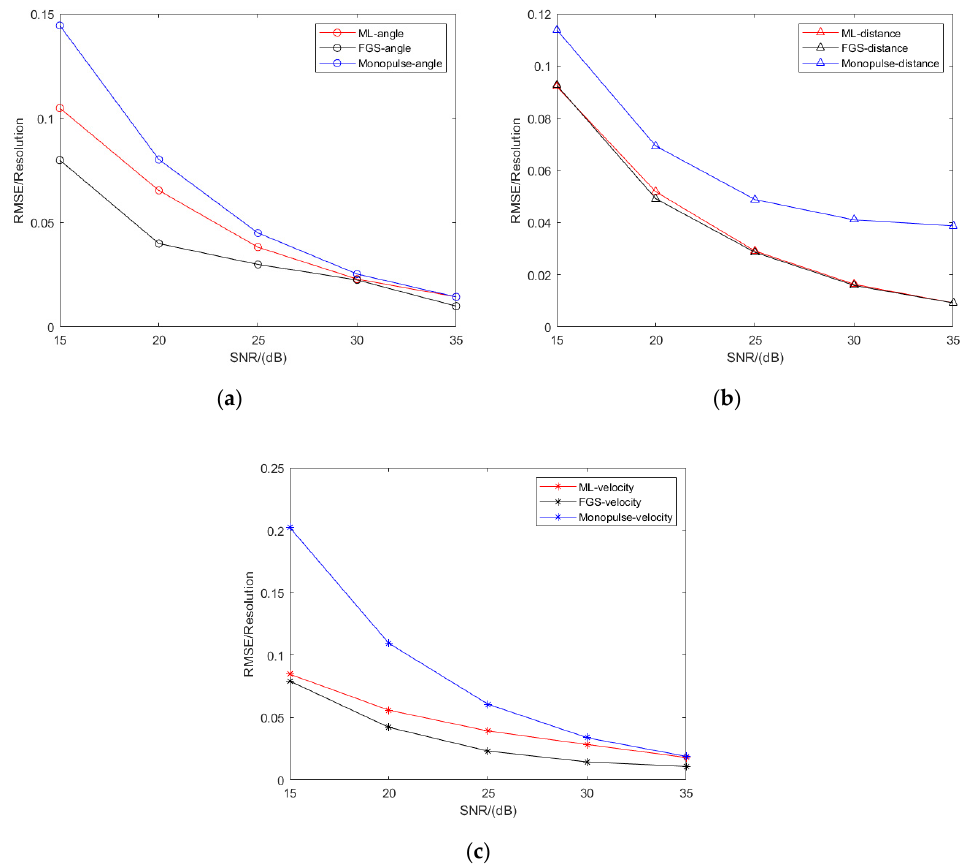
Figure 5. Statistical performance results in SNR cases. ( a ) Angle estimation results; ( b ) Range estimation results; ( c ) Velocity estimation results.